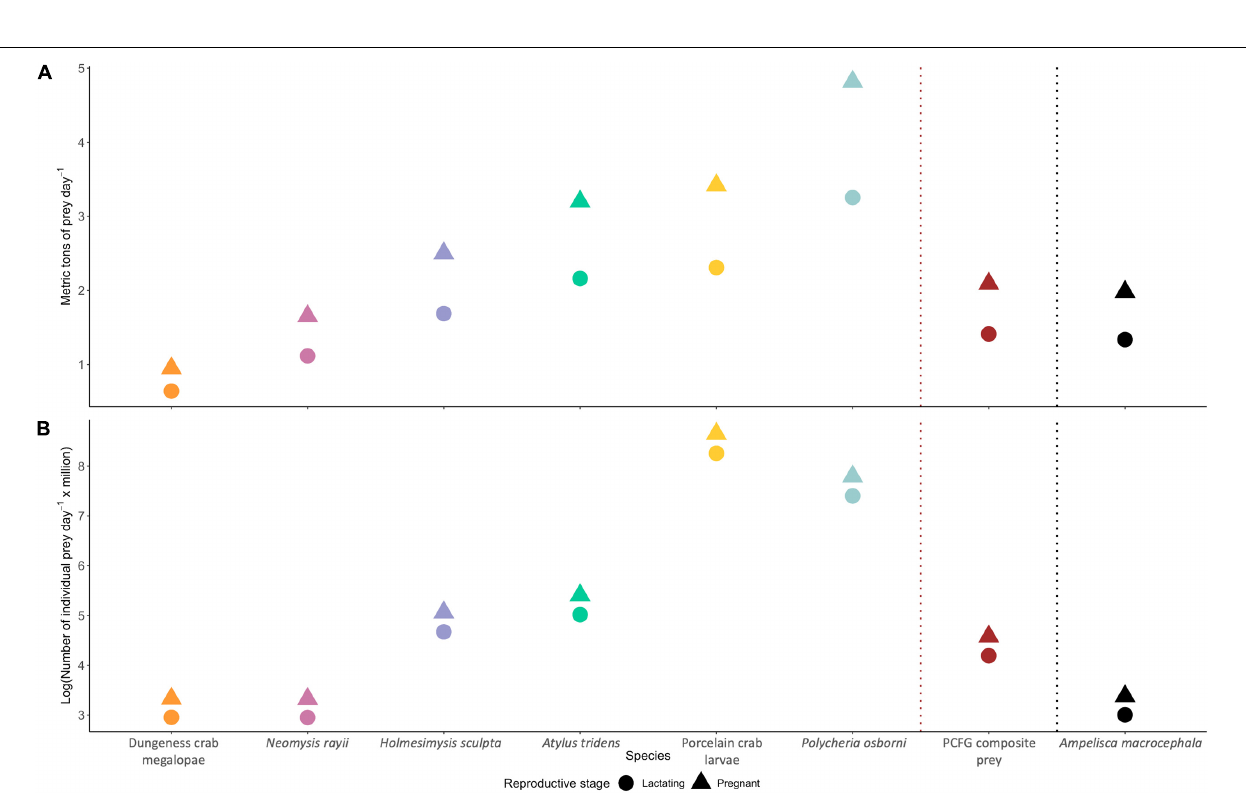
FIGURE 4 | Daily prey requirements ( A: metric tons; B: number of individuals) needed by pregnant and lactating female gray whales to meet their energetic requirements on the foraging ground. Energetic requirement estimates obtained from Villegas-Amtmann et al. (2017). Note logarithmic scale of y -axis in panel (B) .